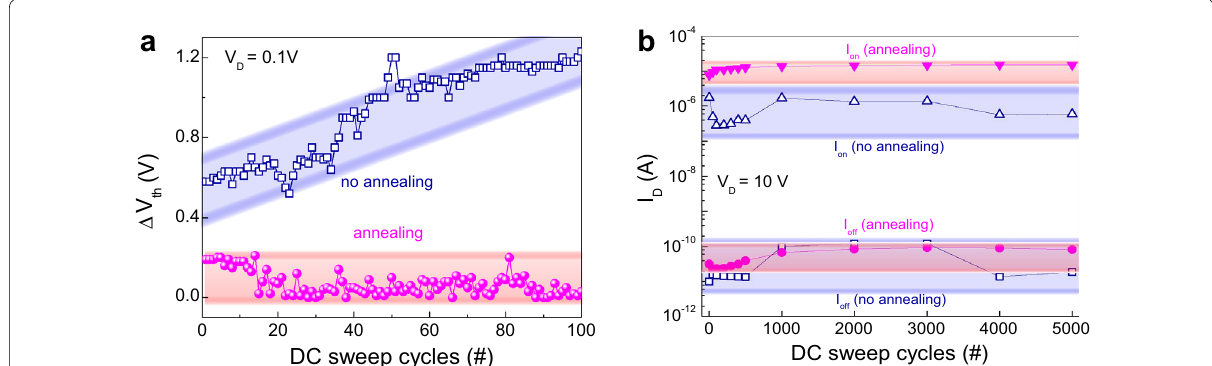
Fig. 5 a Variation in threshold voltage shift during a 100 DC cycling test (V D test (@ V D 10 V) before and after post‑annealing of the IGZO =